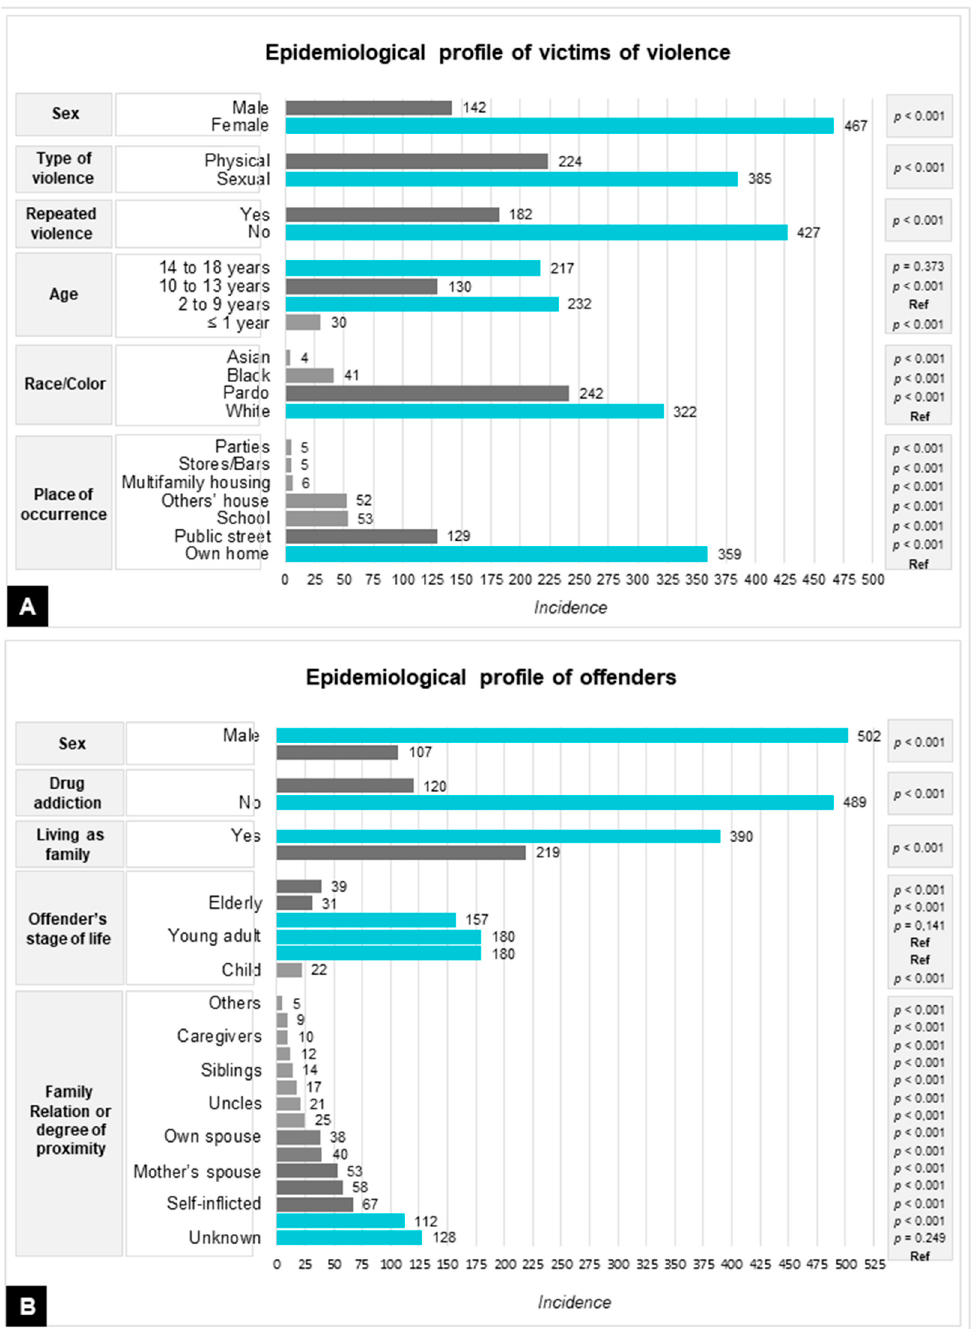
Figure 1. Panel of epidemiological indicators of physical and sexual violence against children and adolescents between July 2016 and December 2020. ( A ) Epidemiological profile of victims of abuse. ( B ) Epidemiological profile of offenders. (Ref) Reference category with higher incidence.